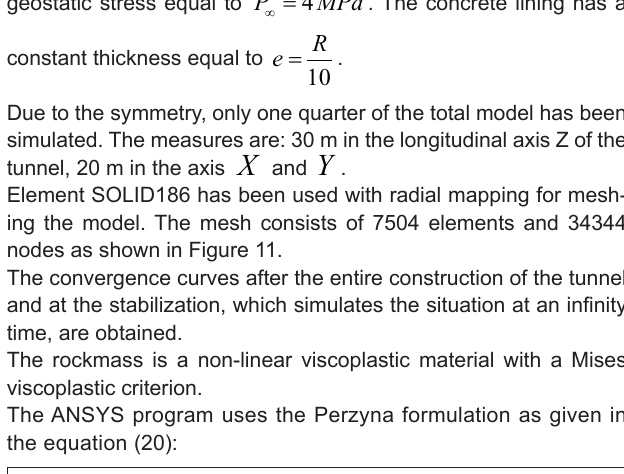
Figure 10 – Convergence curves at validation for lined